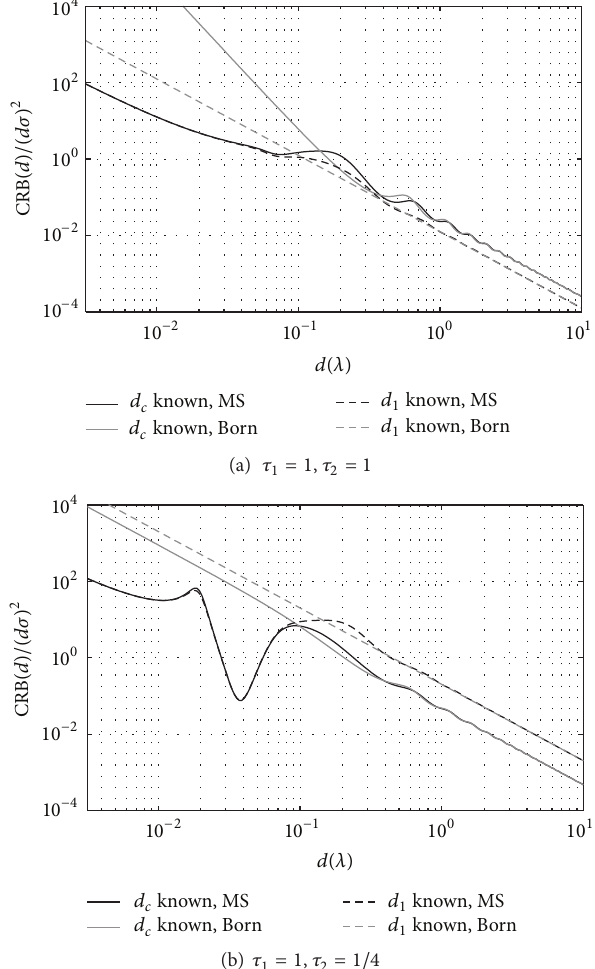
Figure 8: CRB (𝑑) as the scatterer separation 𝑑 varies, normalized by (𝑑𝜎) 2 . The Fisher information on which the bound is based is averaged over all combinations of 100 samples each of incidence angles 𝛼 𝑛 ∈ [0, 𝜋] and observation angles 𝛽 𝑛 ∈ [0, 𝜋] taken at regular intervals. Two variations are shown: (a) equal ( 𝜏 1 = 1 = 𝜏 2 ) and (b) unequal ( 𝜏 1 = 1, 𝜏 2 = 1/4 ) scatterer